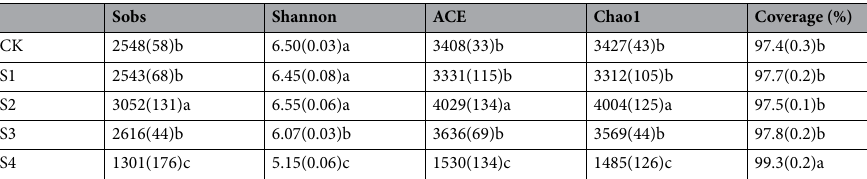
Table 1. The α-diversity and species richness of soil bacteria in the control (CK), low salinity level (S1), medium salinity level (S2), high salinity level (S3), and extreme salinity level (S4) sites. Values are the mean ± standard error. Sobs: the actual observed richness; Shannon: the Shannon diversity index; ACE: Ace index of species richness; Chao1: Chao1 index of species richness. In the table, the significant relationships at p < 0.05 are indicated by different letters based on the DUNCAN test.